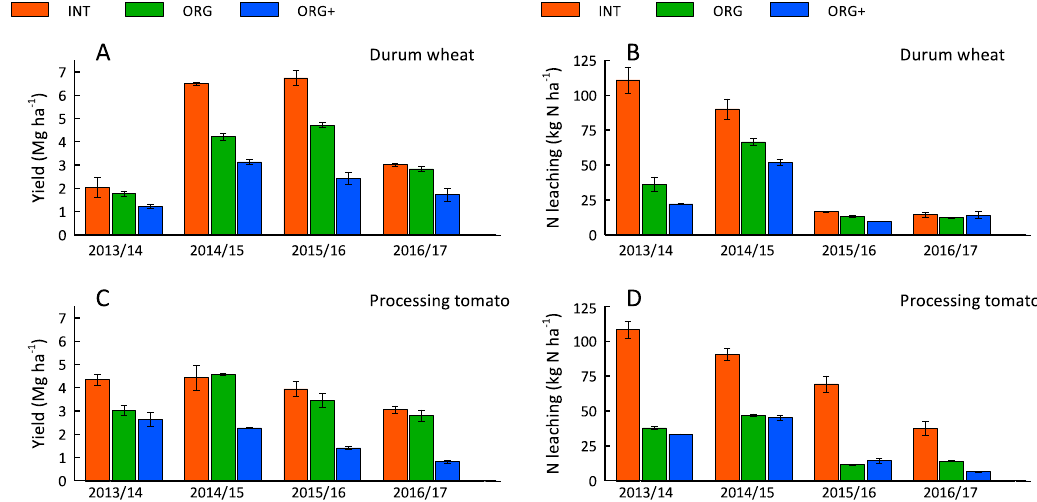
Figure 2. Yield (Mg ha − 1 ) and N leaching (kg N ha − 1 ) of durum wheat (top: A and B , respectively) and processing tomato (bottom: C and D , respectively) in the three cropping systems: integrated (INT), traditional organic (ORG) and innovative organic (ORG+). Bars represent the standard errors.